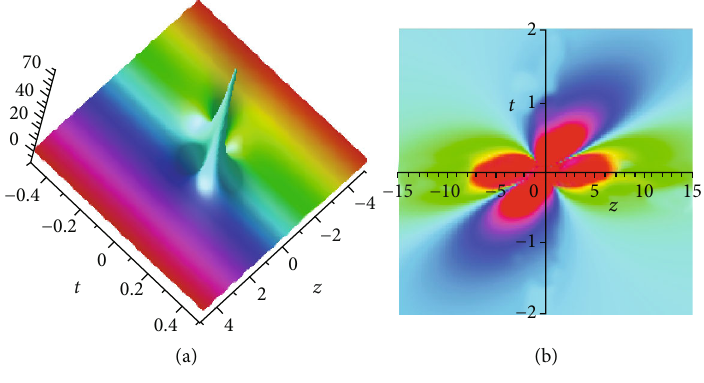
Figure 20: Plots of lump-periodic